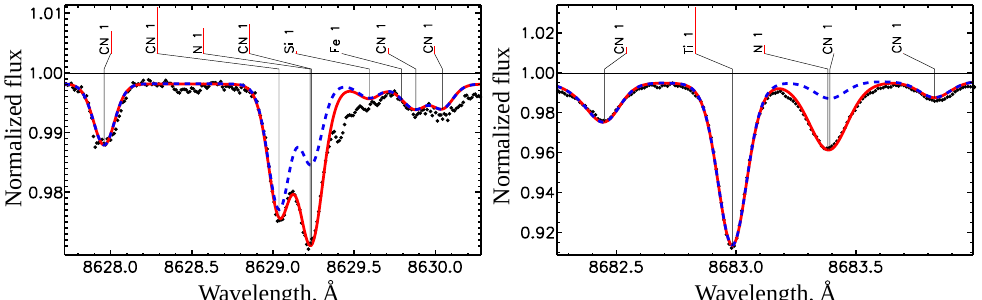
Figure 1. Comparison between the Solar Flux Atlas (black dots) and spectrum synthesis in the regions of N I atomic lines (red line). The blue dashed line shows the theoretical calculations without the N I lines demonstrating a blended